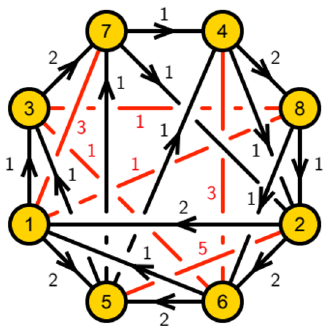
Figure 28 . Quiver for Model